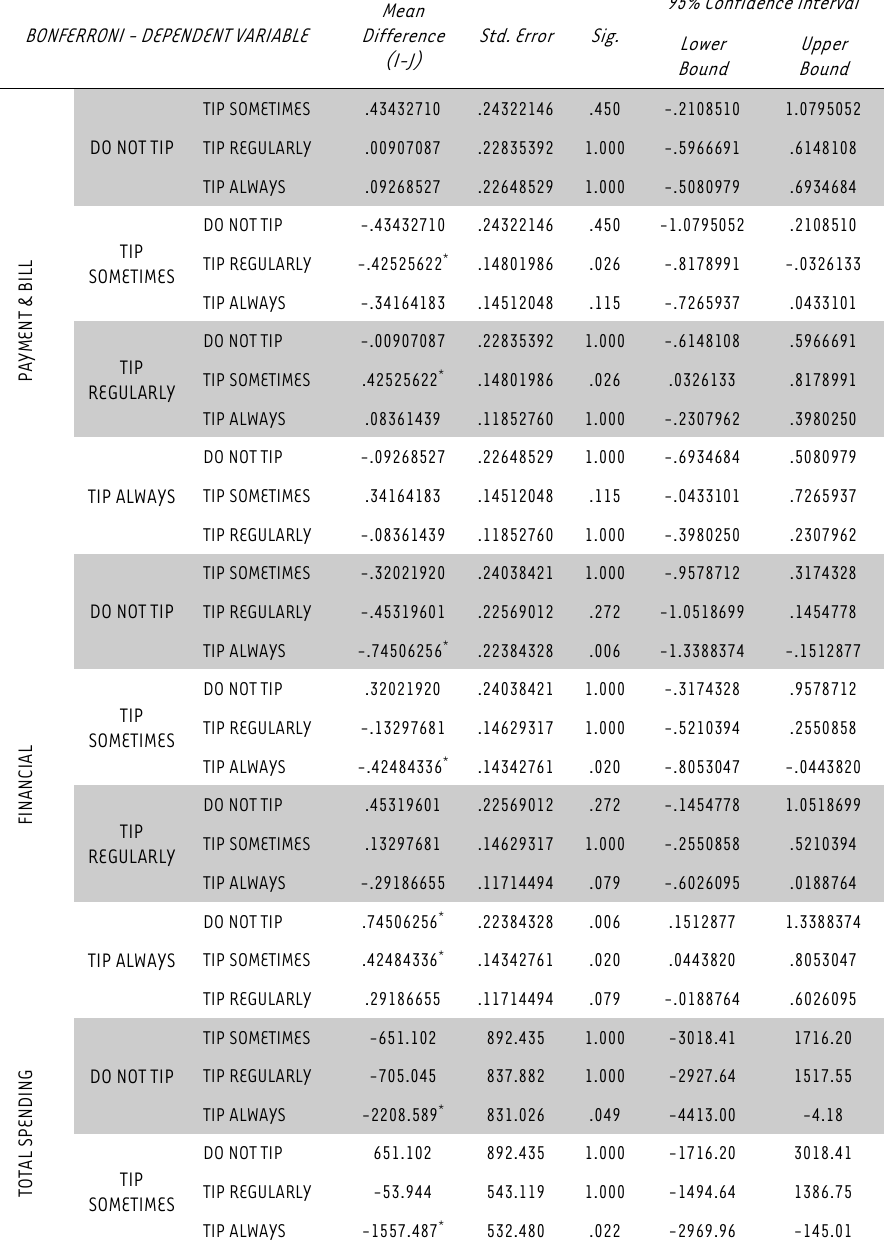
TABLE 5: Bonferroni corrections